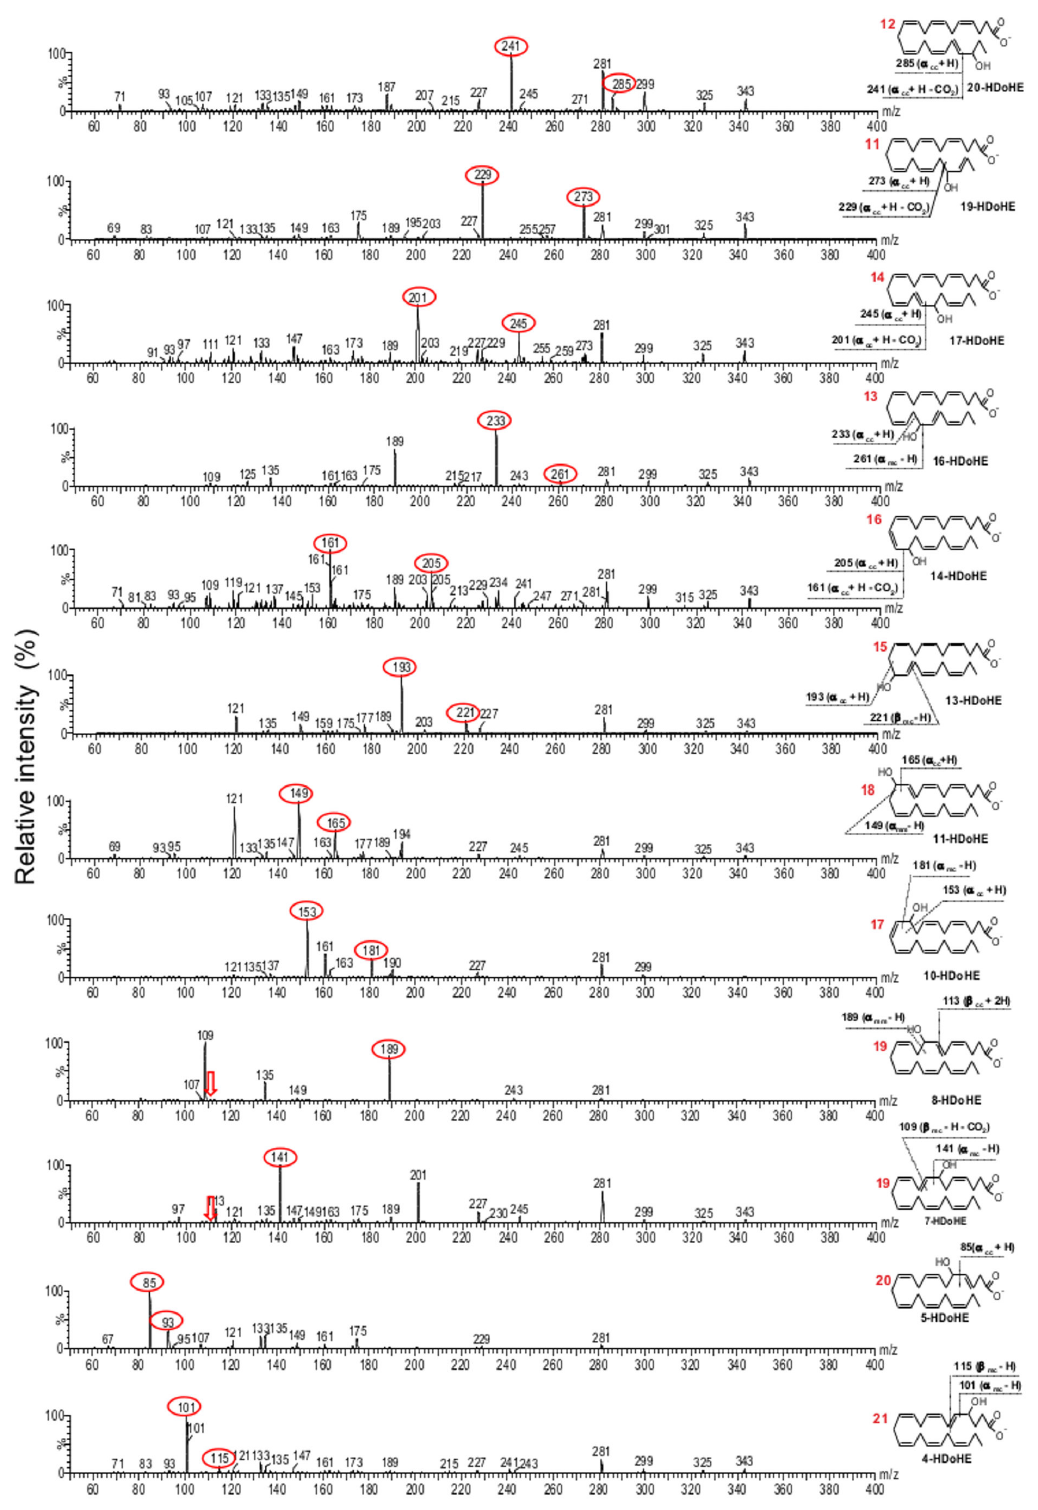
Figure 4. Fragmentation pattern analysis of the HDoHE isomers – MS/MS spectra obtained from m/z 343. The selected fragments for SRM analysis are depicted in each isomer structure. The numbers in red correspond to the peaks observed in the LC- MS analysis (Figure 2). doi: 10.1371/journal.pone.0077561.g004 PLOS ONE |